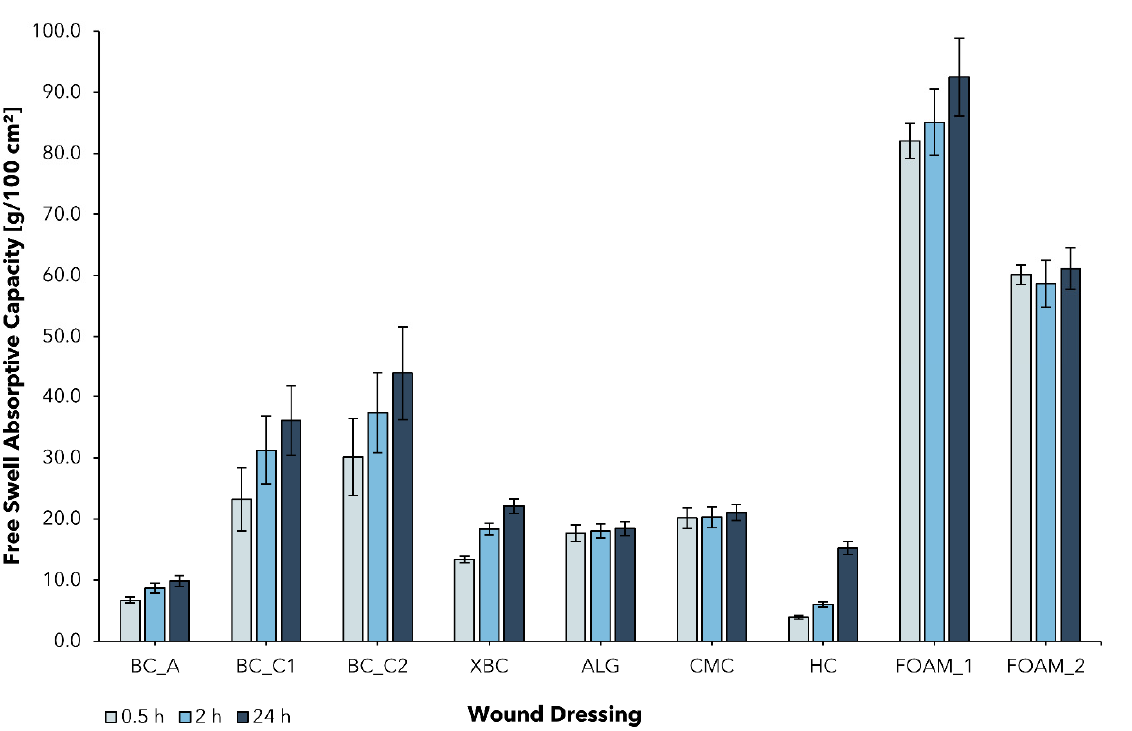
Figure 3. Free swell absorptive capacity (AC) of bacterial cellulose wound dressings and alternative wound care products (mean ± SD; n = 5). The fluid uptake was measured at three successive time points (AC 0.5 ; AC 2 ; AC 24 ) in the same experimental setting for epicite hydro (BC_A); Suprasorb® X (XBC); Suprasorb® A (ALG); Aquacel® Extra™ (CMC); Hydrocoll® (HC); ALLEVYN Gentle (FOAM_1); Mepilex® (FOAM_2).